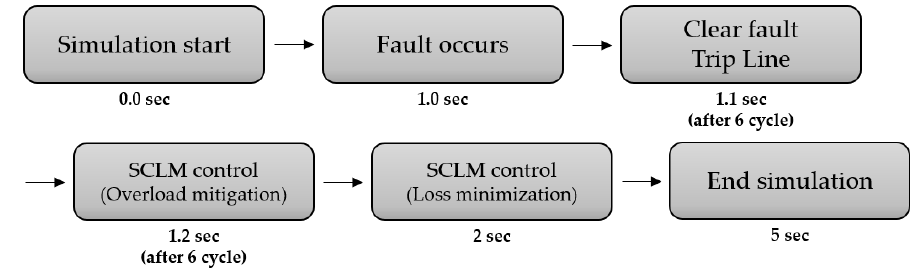
Figure 7. Simulation proceeds for SCLM control.